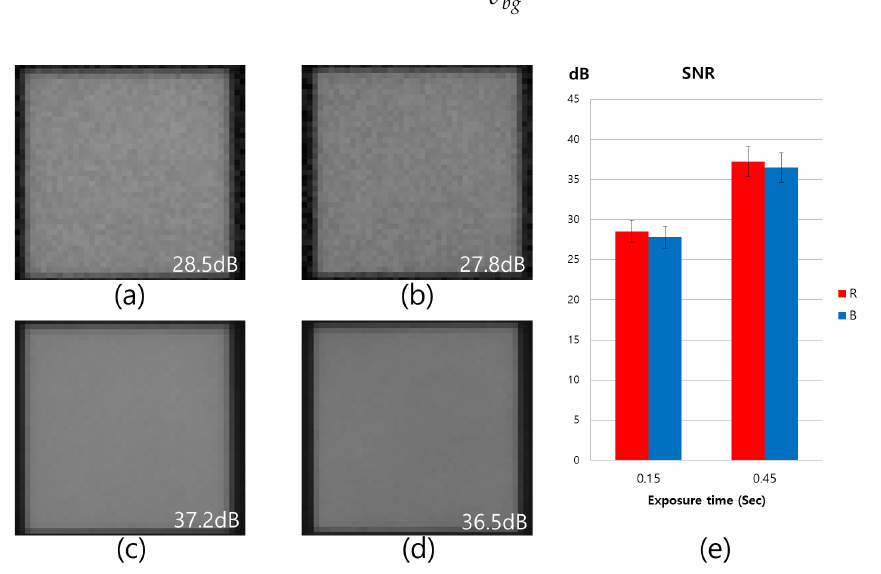
Figure 6. Noise level comparison between different exposure time: ( a ) Red channel (0.15 s); ( b ) Blue channel (0.15 s); ( c ) Red channel (0.45 s); ( d ) Blue channel (0.45 s); and ( e ) signal-to-noise ratio (SNR) versus exposure